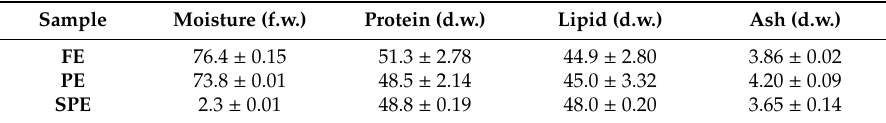
Table 2. Chemical composition (g / 100 g) of egg